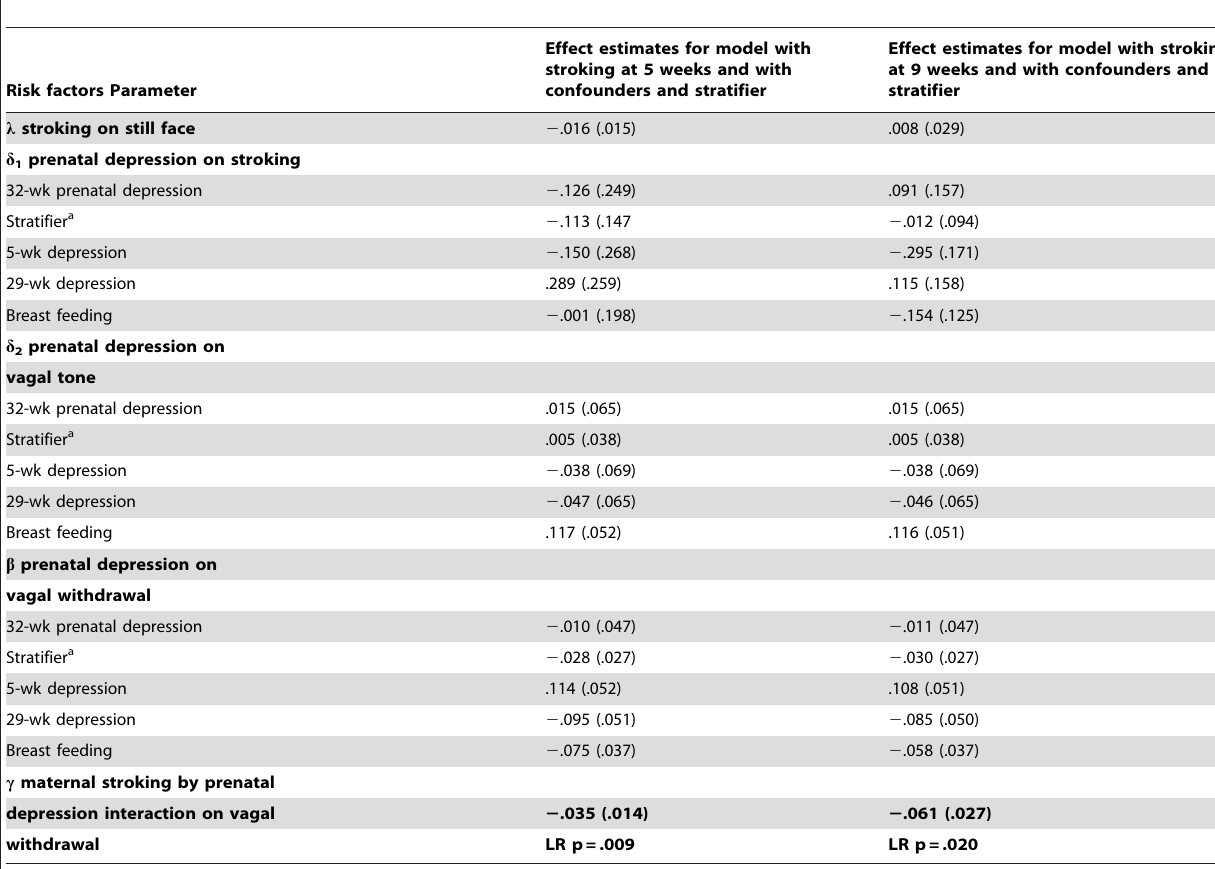
Table 3. Parameter Estimates and Standard Errors for the Vagal Tone (RSA) Model of Figure S2 (which shows the stroking and vagal tone factor loadings) for the effects of stroking with adjustment for stratification and confounders.